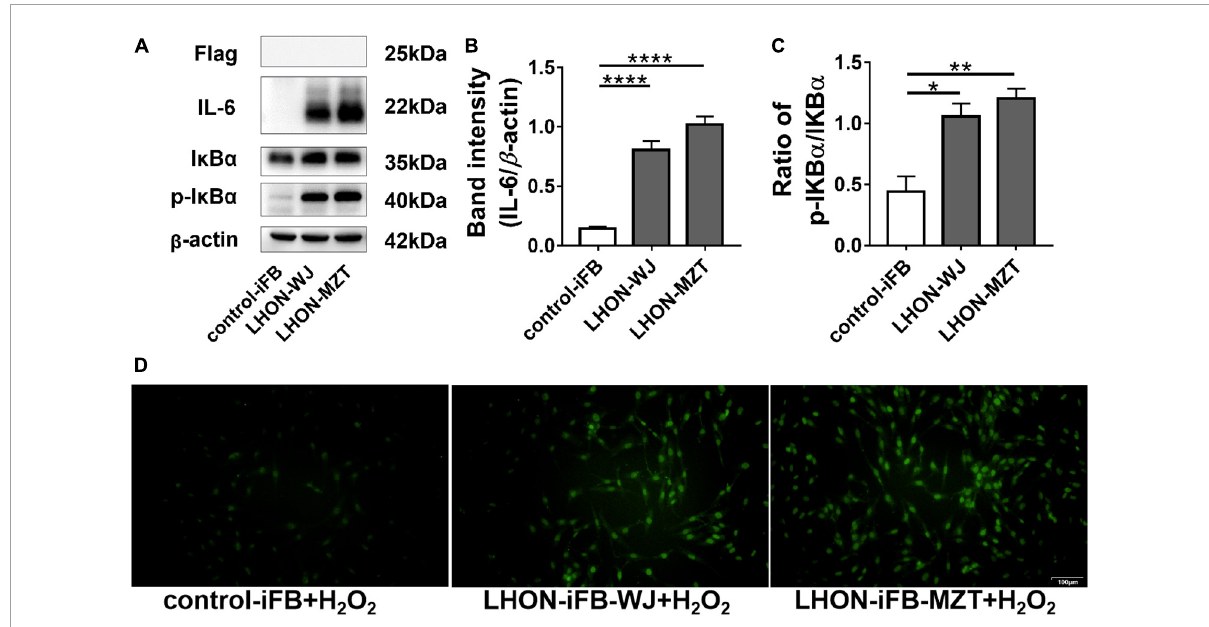
FIGURE2 LHON-iFBs presented inflammatory response and increased apoptosis. Western blot showed that (A,B) protein levels of IL-6 and (A,C) the ratio of p-I κ B α to I κ B α were upregulated robustly in LHON-iFB compared to control-iFB. (D) TUNEL assay was performed in LHON-iFBs and control-iFB treated with same concentration of hydrogen peroxide for 12 h. The results (mean ± SD) were statistically significant (* p < 0.05, ** p < 0.01, **** p < 0.0001, n = 3–4) by using one-way ANOVA with Bonferroni correction, and the assays were performed three